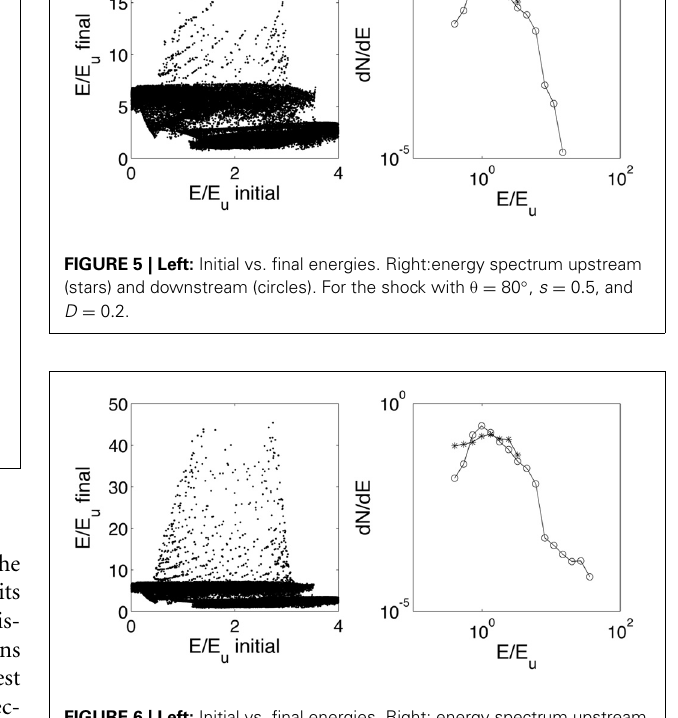
FIGURE 6 | Left: Initial vs. final energies. Right: energy spectrum upstream (stars) and downstream (circles). For the shock with θ = 80 ◦ , s = 0 . 5, and D = 0 . 1.